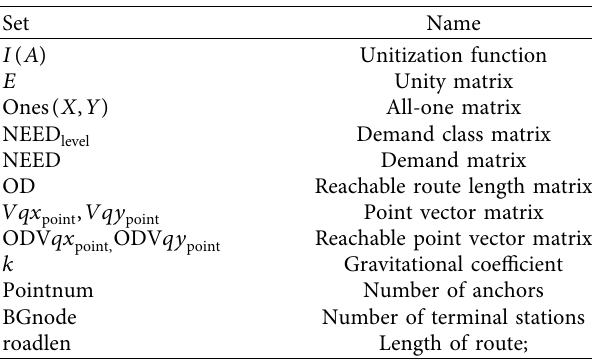
Table 1: Notation and name in the